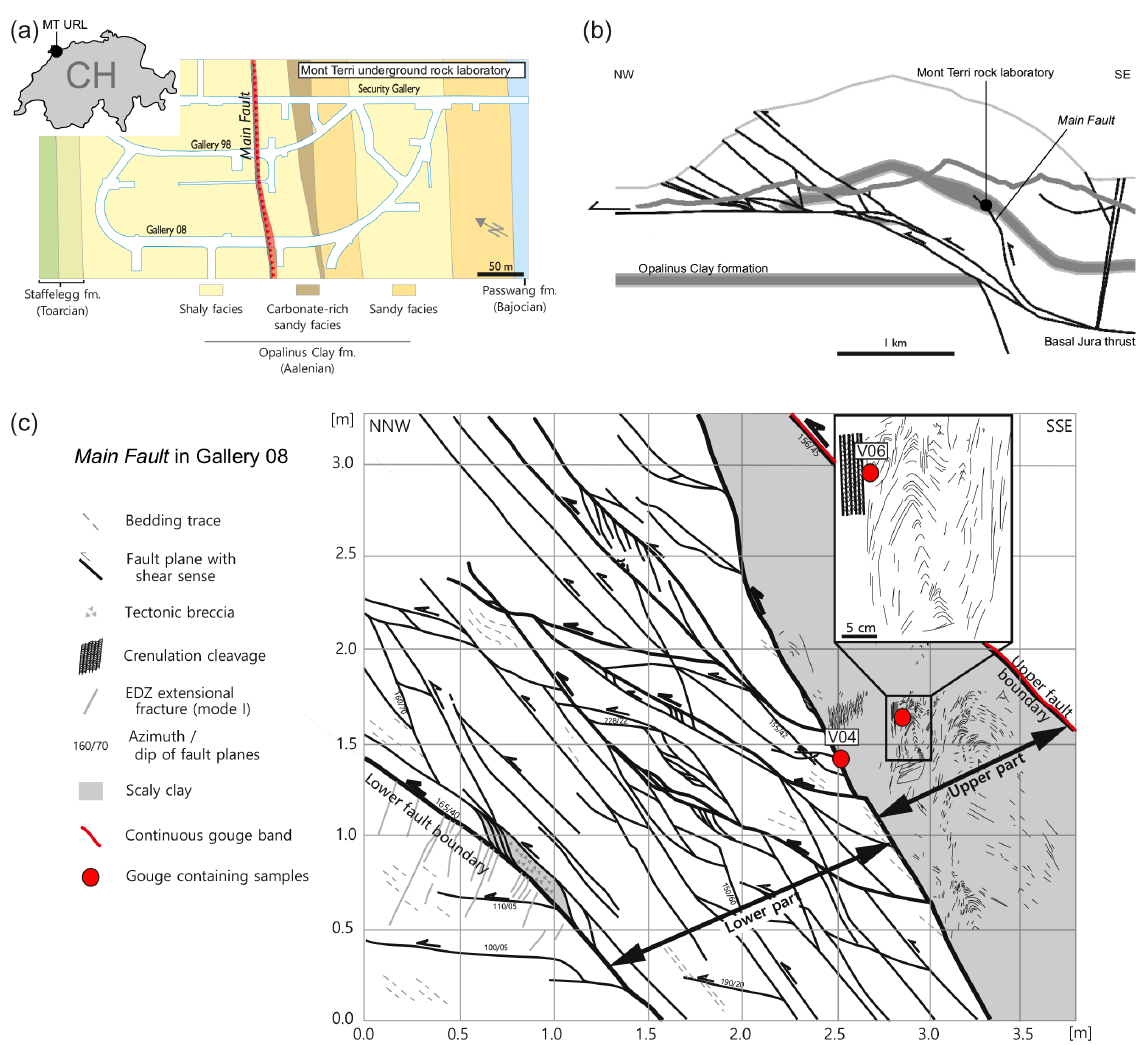
Figure 1. (a) Location map of the Main Fault in the Mont Terri research laboratory, (b) cross section modified from Freivogel and Huggen- berger (2003) and (c) outcrop sketch of the Main Fault in gallery 08 modified from Nussbaum et al.